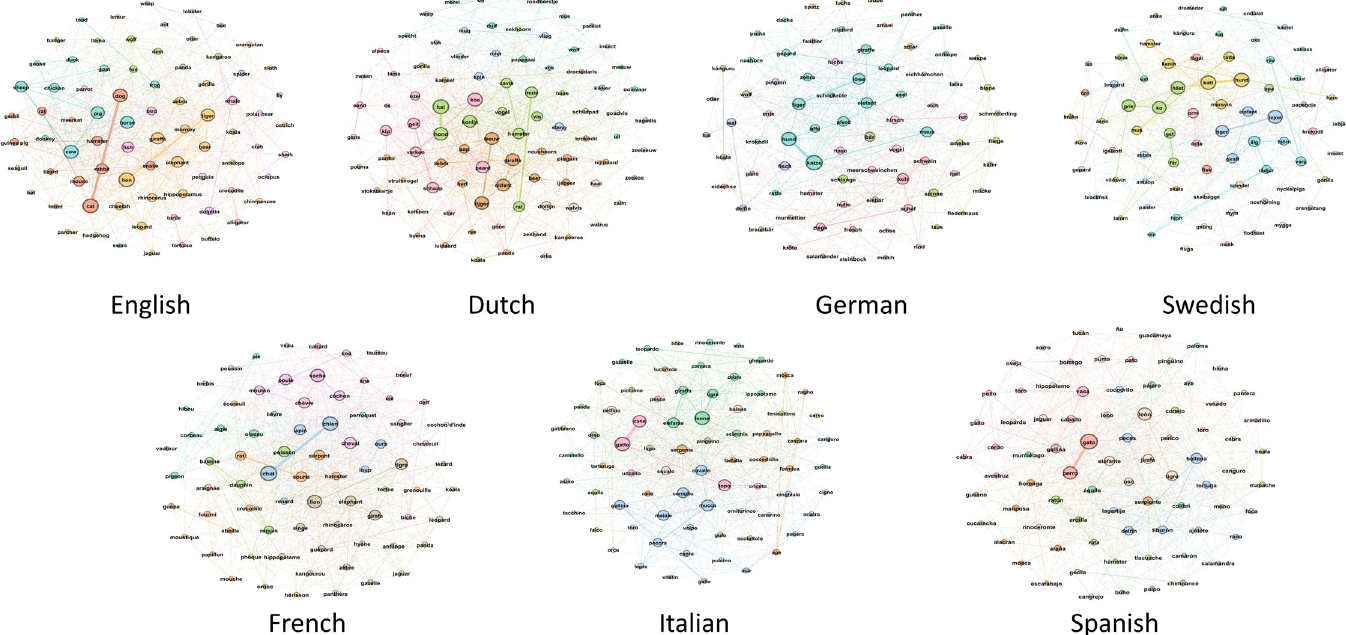
Fig 5. Core animal concepts across seven languages. Nodes indicate terms, links indicate co-occurrence, and colours indicate clusters within each language.